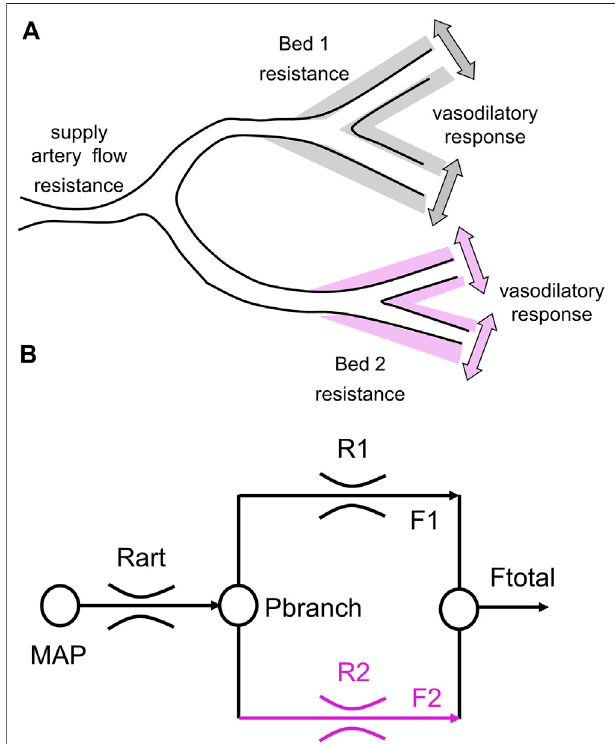
FIGURE 1 | A simple 2-vascular-bed model of a cerebral vascular region. (A) A theoretical illustration of two brain vascular territories both supplied in parallel by a major supply artery with resistance. Their vasodilatory responses are shown as shading. (B) A simple resistance circuit model. Reference and examined vascular beds with resistances R1 and R2 are perfusedviaanarterial fl owresistance( Rart )frommeanarterialbloodpressure ( MAP ). The pressure perfusing the two branches (Pbranch) and their respective resistances establishes fl ows through each branch (F1 and F2), that sum to Ftotal. Given F1 and F2 as BOLD measures for the reference and examined voxels, R1 and R2 can be calculated by considering the model as an analog of an electrical circuit (From Duf fi n et al.,